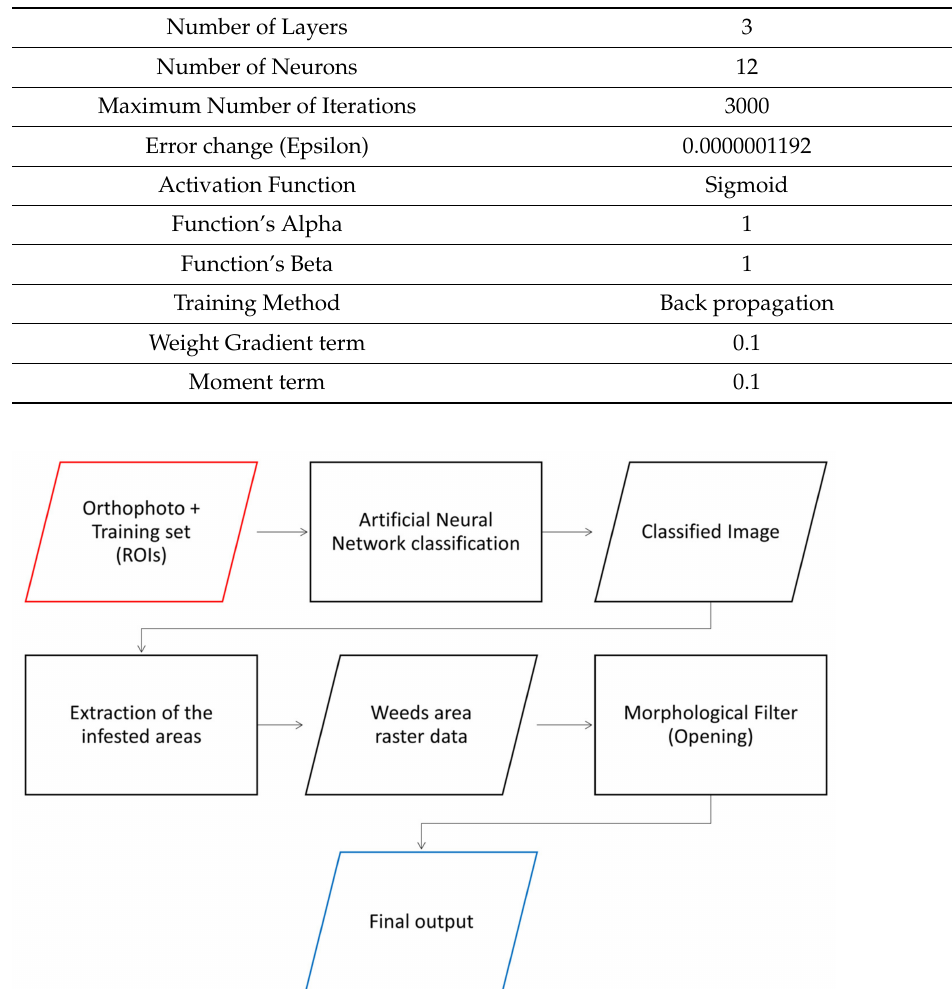
Figure 3. Workflow of the Artificial Neural Network weed mapping method: the only difference with the workflow shown in Figure 2 is in the first process, i.e., the classification